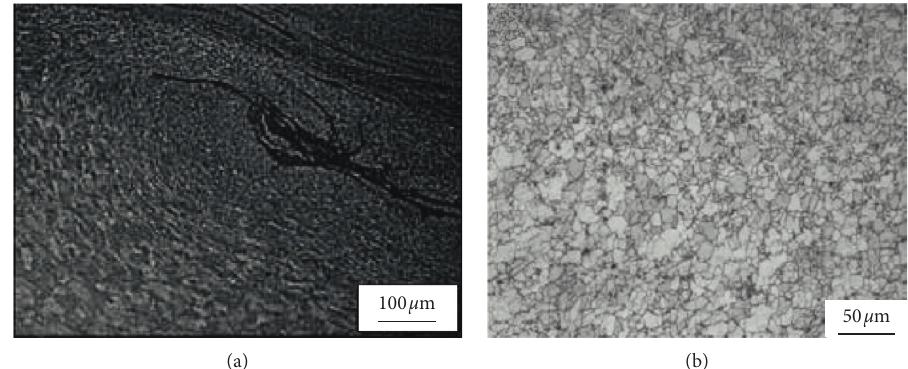
Figure 5: Microstructure of each area on two sides of the joint steel sheet. (a) Microstructure of the joint zone. (b) Microstructure of HAZ.